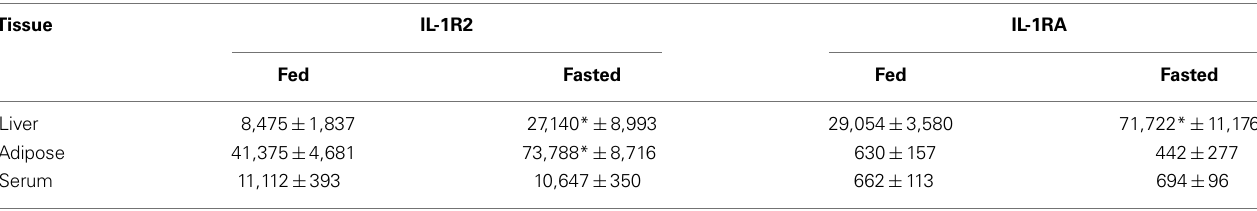
Table 3 | Effect of fasting on IL-1R2 and IL-1RA protein levels